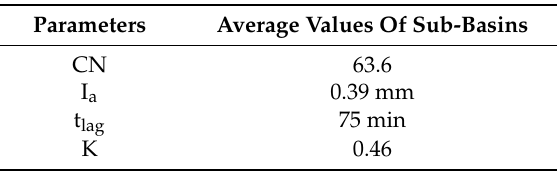
Table 7. Calibrated parameters of the 2010s.